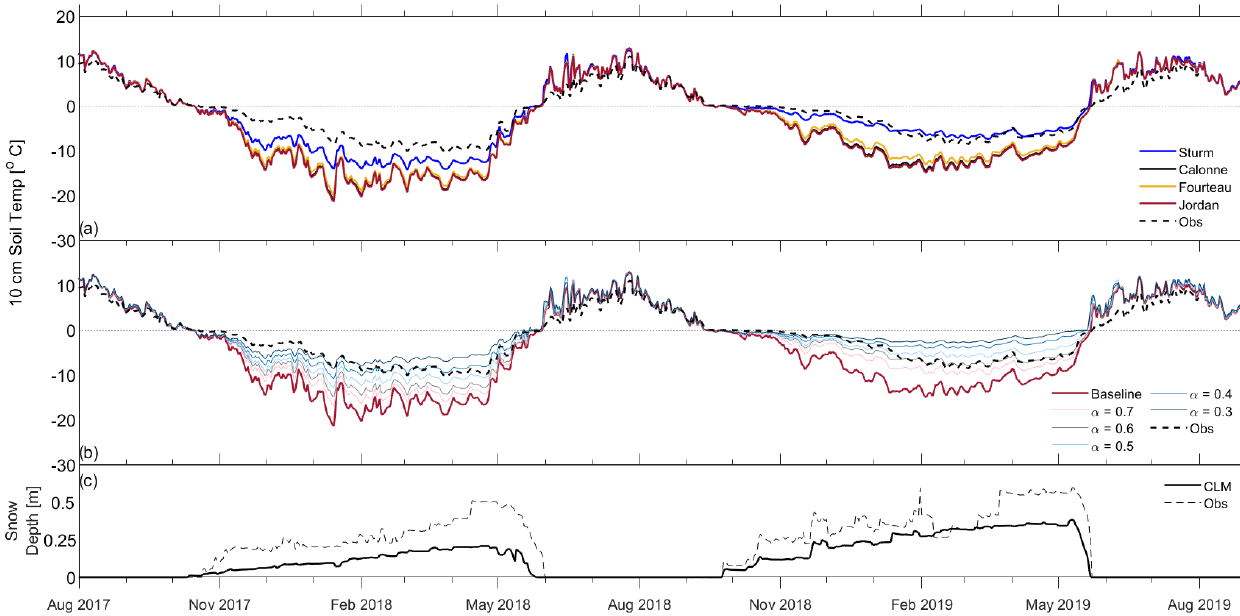
Figure 7. (a) Simulated 10cm soil temperature time series using the four different parameterisations of snow thermal conductivity compared to field measurements. (b) Time series of 10cm soil temperatures when using different values of the correction factor α compared to field measurements. (c) Observed and simulated snow depths for the same time